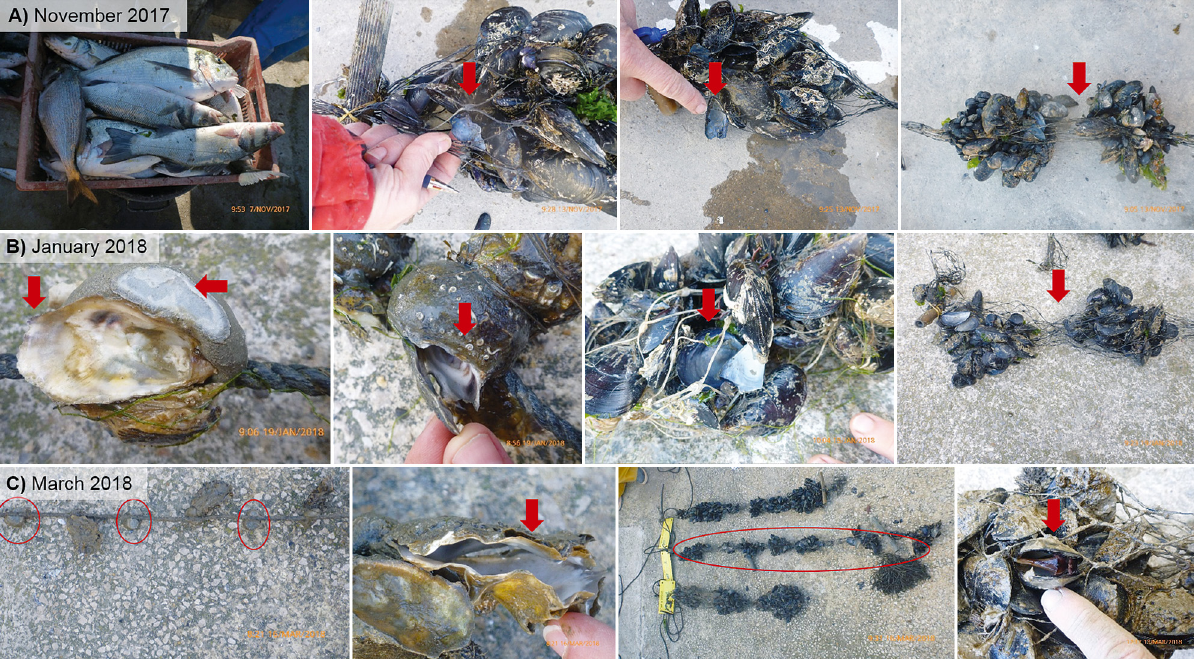
Fig. 9. (A) Large seabream fished in November 2017 and signs of predation on mussel and oyster ropes in November 2017, (B) January 2018, and (C) March 2018 when seabream were not detected by the receiver in the farm. Dates are shown in the lower right corner of each